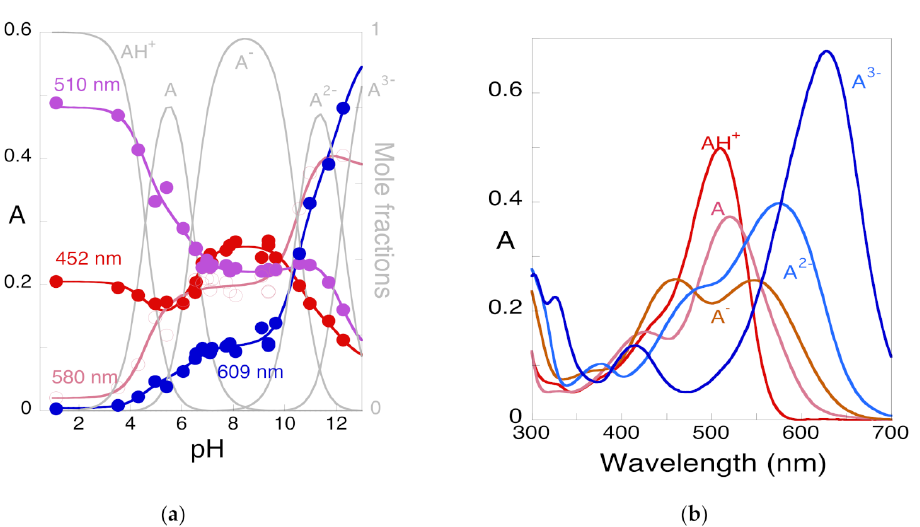
Figure 5. ( a ) Mole fraction distribution of the kuromanin (1.5 × 10 − 5 M) flavylium cation and quinoidal base species obtained 10 ms after a direct pH jump followed by stopped flow; p K a1 = 4.0; p K a2 = 6.5; p K a3 = 10.0; p K a4 = 12.2; ( b ) Spectral decomposition achieved for obtained p K a